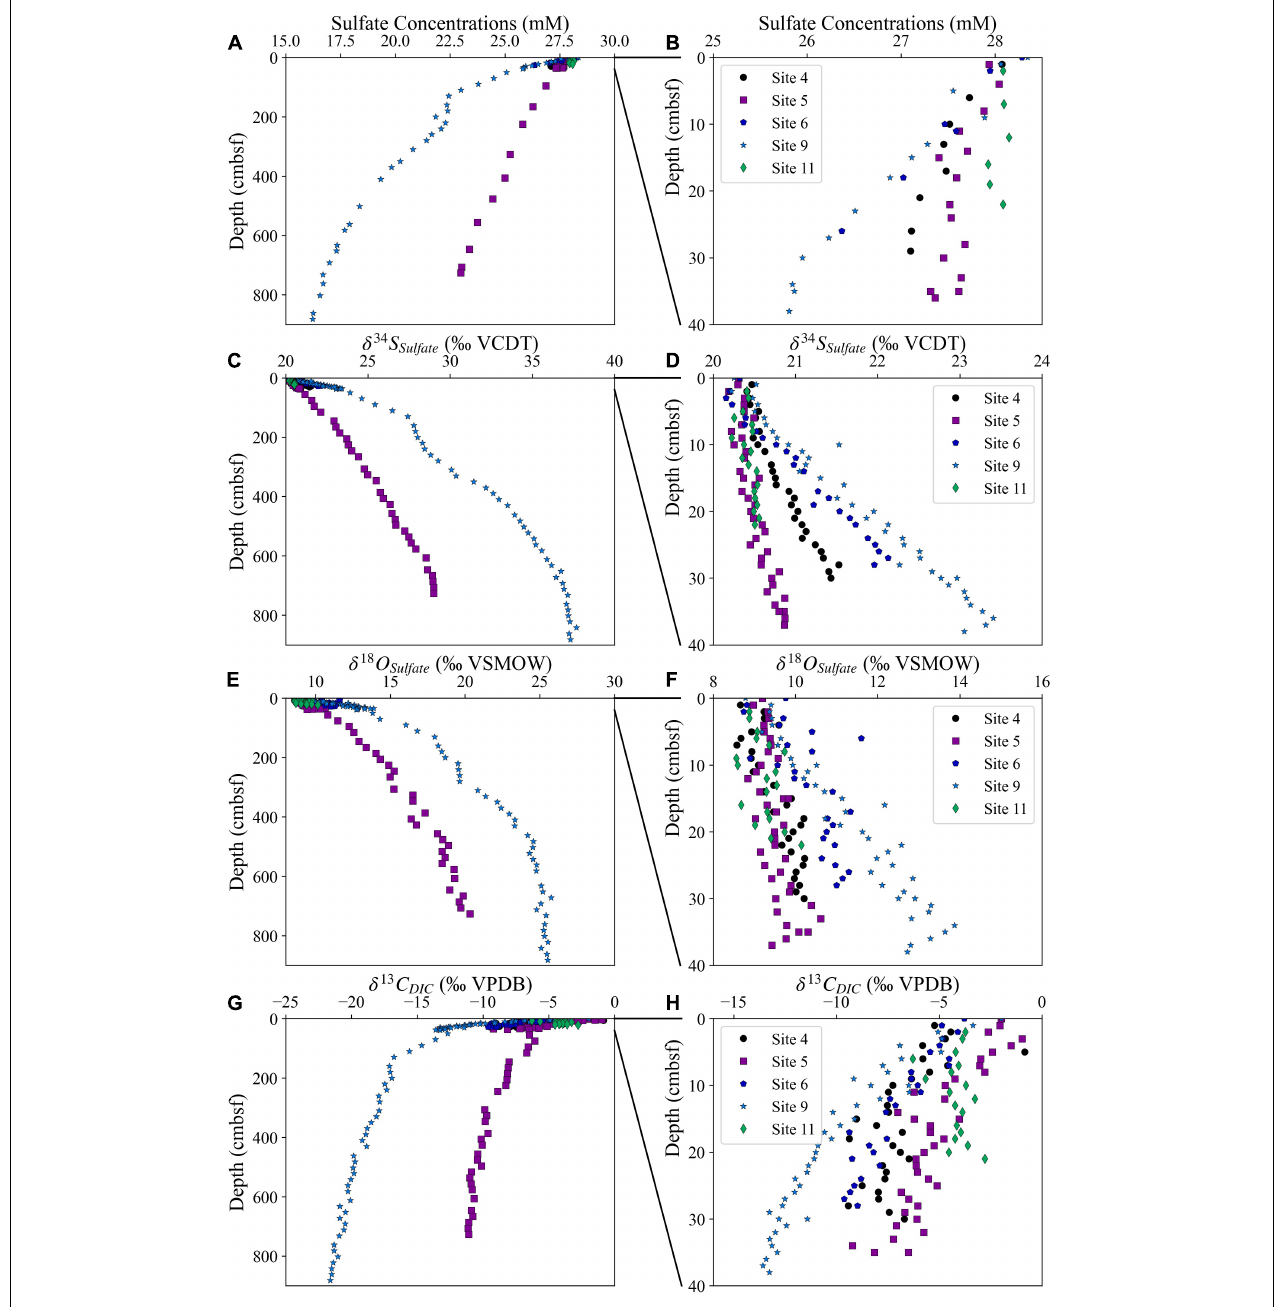
FIGURE 2 | The sulfate concentrations from two piston and three multi cores (A,B) , sulfur and oxygen isotopic composition of sulfate (C–F) and carbon isotopic composition of the DIC (G,H) . Panels (A,C,E,G) display measurements over the entire depth range of the piston cores, whereas panels (B,D,F,H) display the same measurements over 40 cm below seafloor